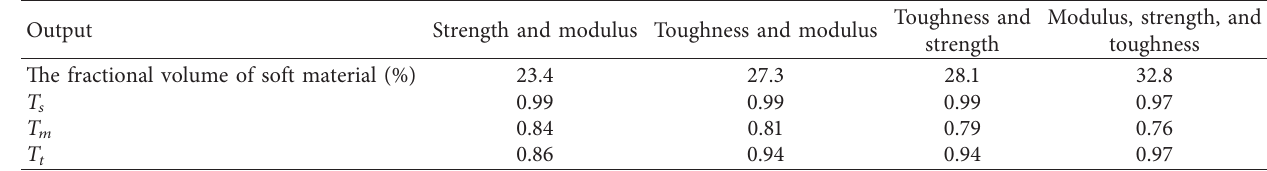
Table 4: Results of optimization using